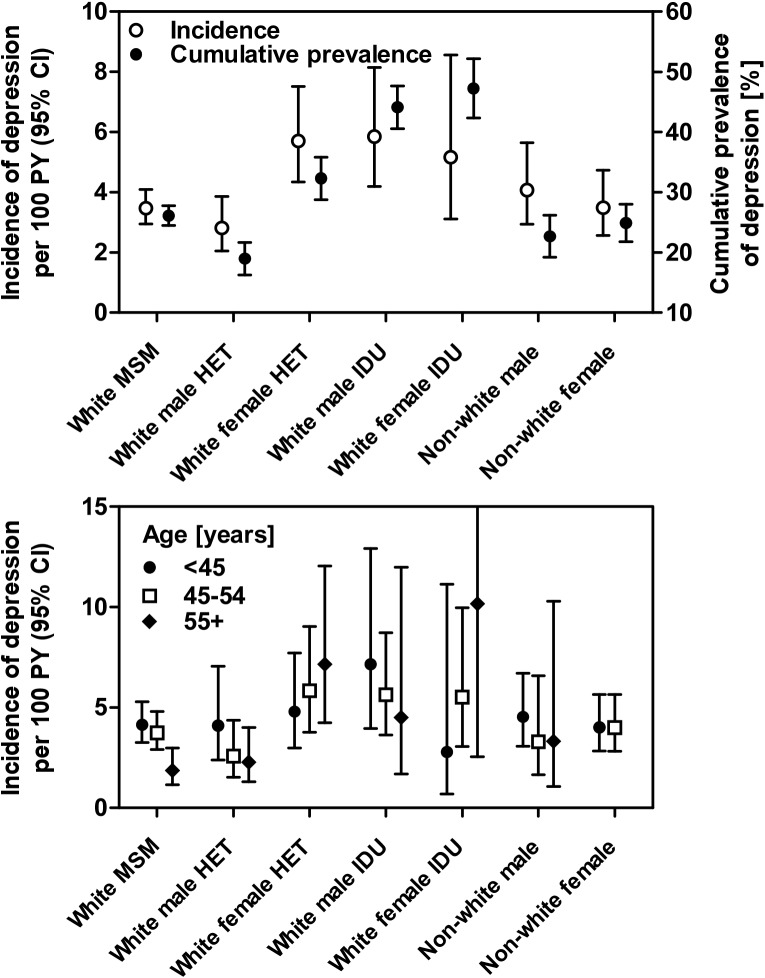
The top panel shows the incidence of depression among 4,422 individuals (360 events during 9,348 person years) without depression at the first two visits since January 2010 and cumulative prevalence of depression at the last follow-up among 6756 persons seen since January 2010 (1937 events).The bottom panel displays the incidence of depression stratified by risk and age groups. Tests for trend across age groups were MSM: P = 0.004, heterosexual men: P = 0.007, and women: P = 0.53. Abbreviations: PY, person years; MSM, men who have sex with men; HET, heterosexually infected person; IDU, injection drug user.